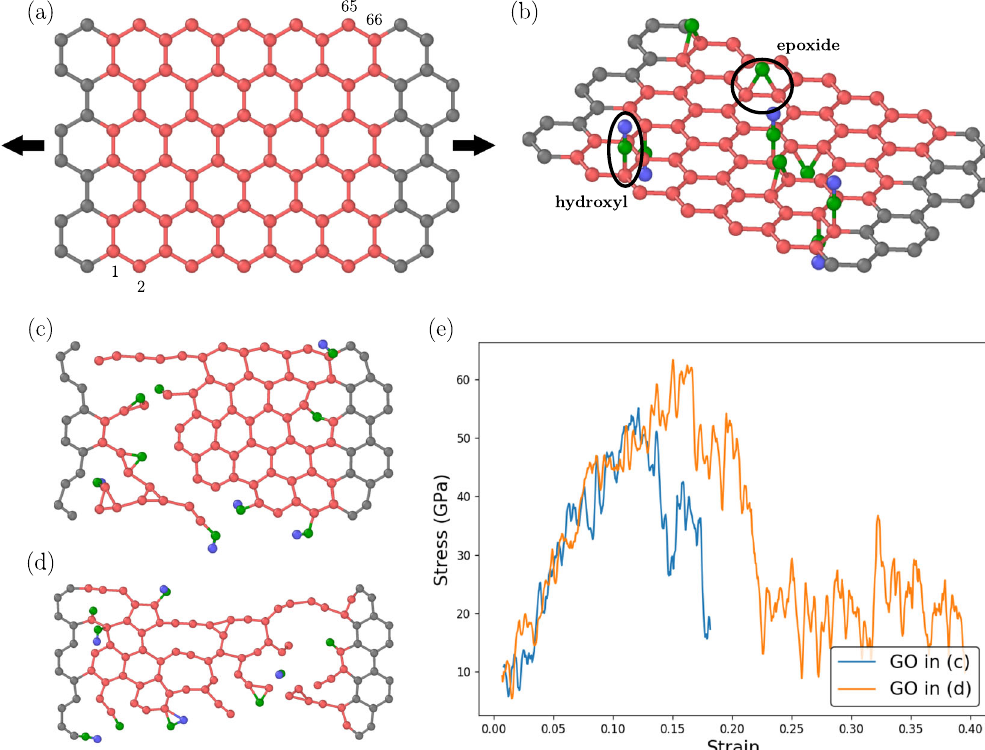
Fig. 1 GO schematics and mechanical responses. a Schematic of GBP, where red atoms (66 in total) are hosts for functional groups while gray atoms are functional group-free atoms on which the tensile loading is exerted. Arrows show the loading direction. b Illustrations of hydroxyl and epoxide groups, where green and blue atoms are oxygen and hydrogen atoms, respectively. c Fracture of a low-toughness GO under tension. d Fracture of a high-toughness GO under tension. e Stress-strain curves of GOs in c and d